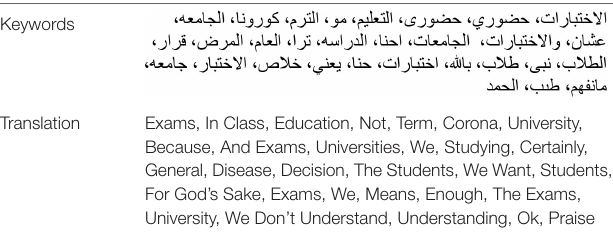
Table 7 | The keywords and their English translation for Figure 7